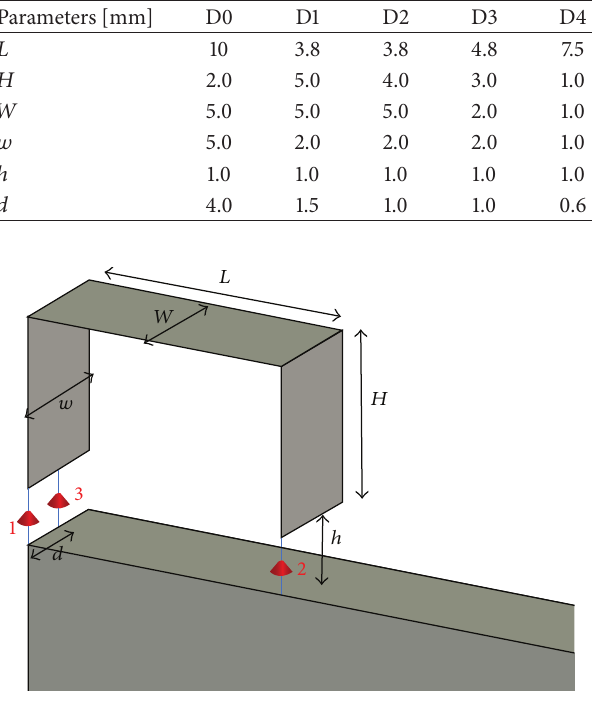
Figure 5: High-band antenna design.